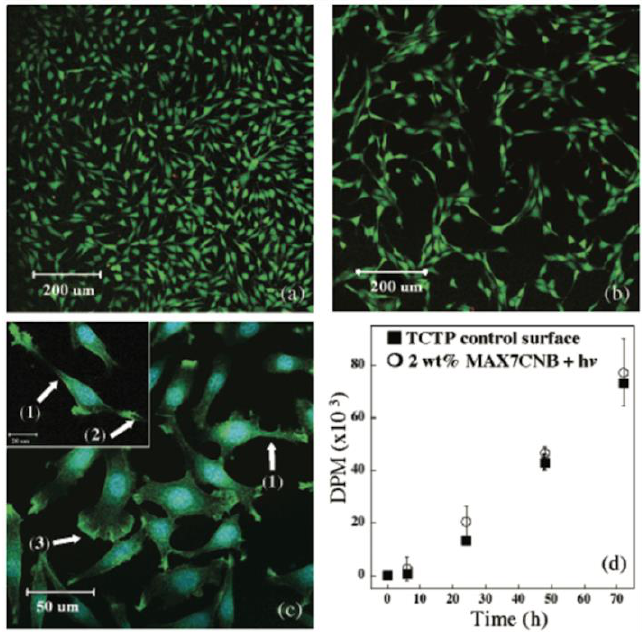
proliferation measured by [ 3 H]thymidine uptake of NIH3T3 fibroblasts seeded onto β -hairpin